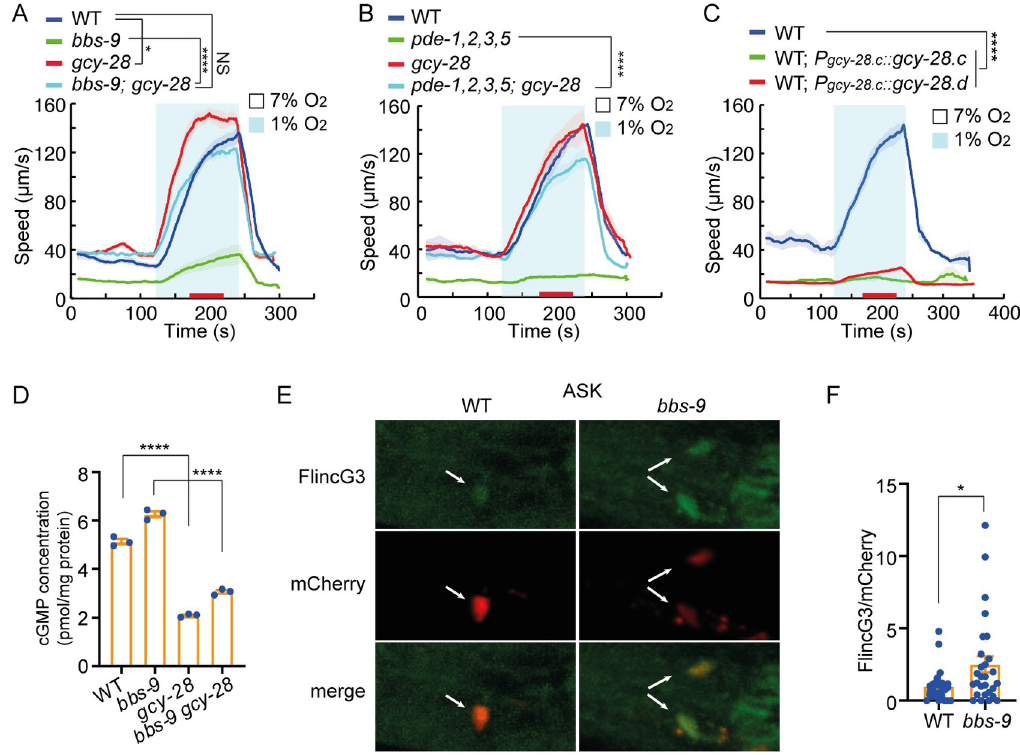
Fig 3. Disrupting GCY-28 suppresses the hypoxia response defects of bbs-9 mutants. (A–C) Locomotory responses to 7% to 1% O 2 stimuli for animals of the indicated genotypes: WT, bbs-9(gk471) , gcy-28(yum32) , and bbs-9(gk471); gcy-28(yum32) double mutants (A); WT, pde-1(nj57); pde-2(tm3098); pde-3(nj59); pde-5(nj49) quadruple mutants ( pde-1 , 2 , 3 , 5 ), gcy-28 (yum39) , and gcy-28(yum39) ; pde-1 , 2 , 3 , 5 (B); and gcy-28 . c and gcy-28 . d cDNA overexpressed from the gcy-28 . c promoter in the WT background (C). ���� = p < 0.0001, � = p < 0.05, NS = not significant. ANOVA, Tukey multiple comparison. (D) Total cGMP in worm lysates determined by cGMP enzyme immunoassay of indicated genotypes ( n = 3): WT, bbs-9(gk471) , gcy-28 (yum32) , and bbs-9(gk471); gcy-28(yum32) . ���� = p < 0.0001. ANOVA, Tukey multiple comparison. (E) Representative images of the genetically encoded cGMP sensor FlincG3 expressed together with a mCherry marker in ASK neurons using the sra-9 promoter and imaged in WT and bbs-9(gk471) mutants. Arrows point to neuronal cell bodies. (F) Quantitation of FlincG3 fluorescent signal intensity in ASK neurons normalized to mCherry fluorescence intensity. � = p < 0.05, t test. The underlying data can be found in S1 Data, and the source code can be found at https://github.com/wormtracker/zentracker. O 2 , oxygen; WT, wild-type.